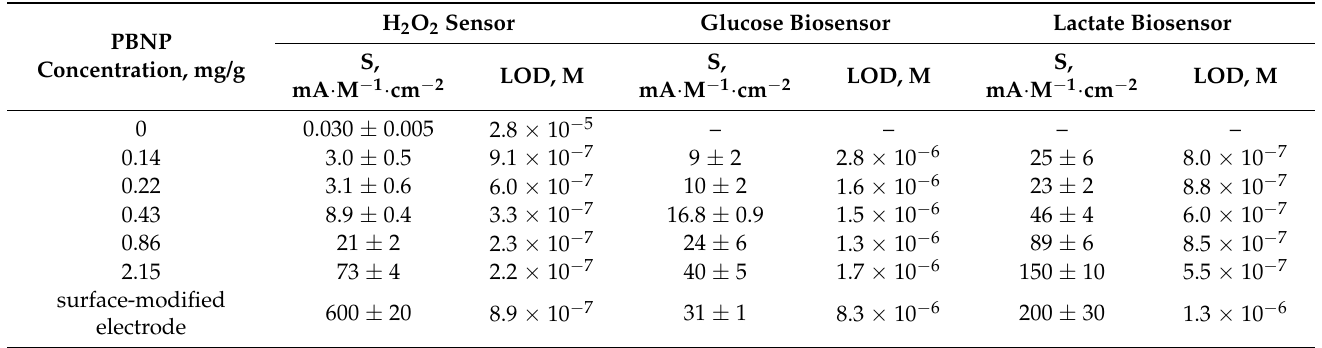
Table 1. Analytical performance of (bio)sensors based on printed electrodes. PBNP